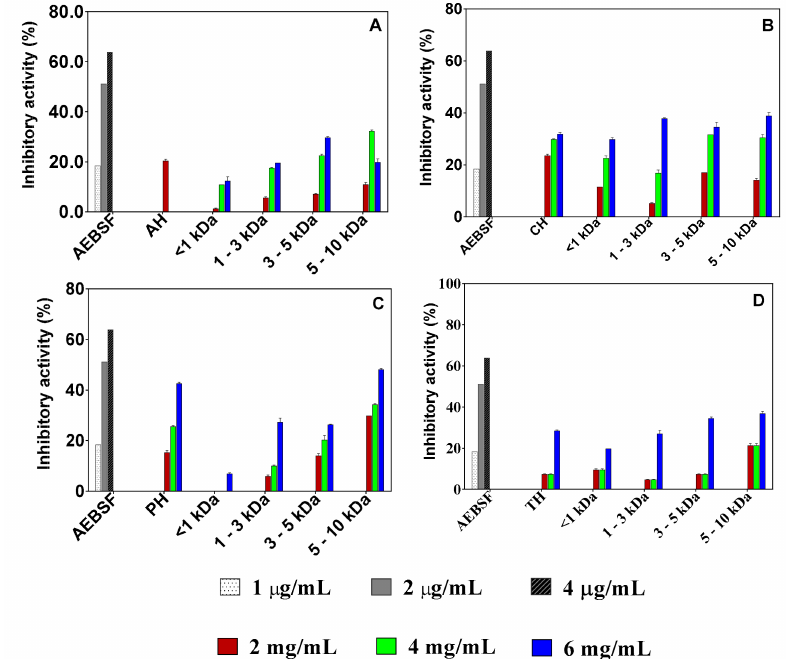
Figure 3. Concentration-dependent inhibition of chymotrypsin activity by 4-(2-Aminoethyl) benzenesulfonyl fluoride hydrochloride (AEBSF) in comparison to those of protein hydrolysates (AH, alcalase hydrolysate; CH, chymotrypsin hydrolysate; PH, pepsin hydrolysate; TH, trypsin hydrolysate) and peptide fractions obtained with alcalase ( A ), chymotrypsin ( B ), pepsin ( C ), and trypsin ( D ). Results are presented as mean ± standard